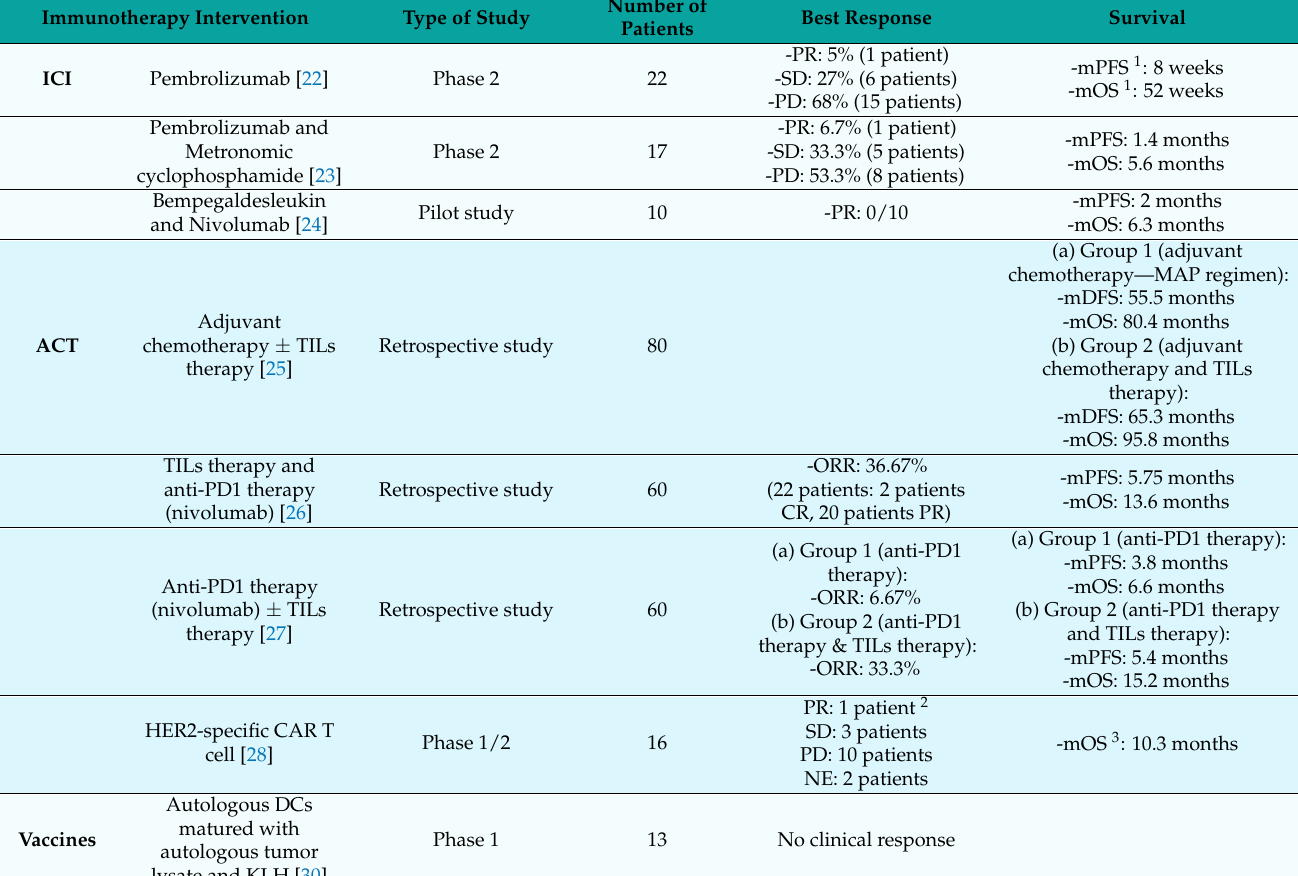
Table 1. Clinical experience of immunotherapy in patients with osteosarcoma (selected studies). Number of Immunotherapy Intervention Type of Study Best Response Patients